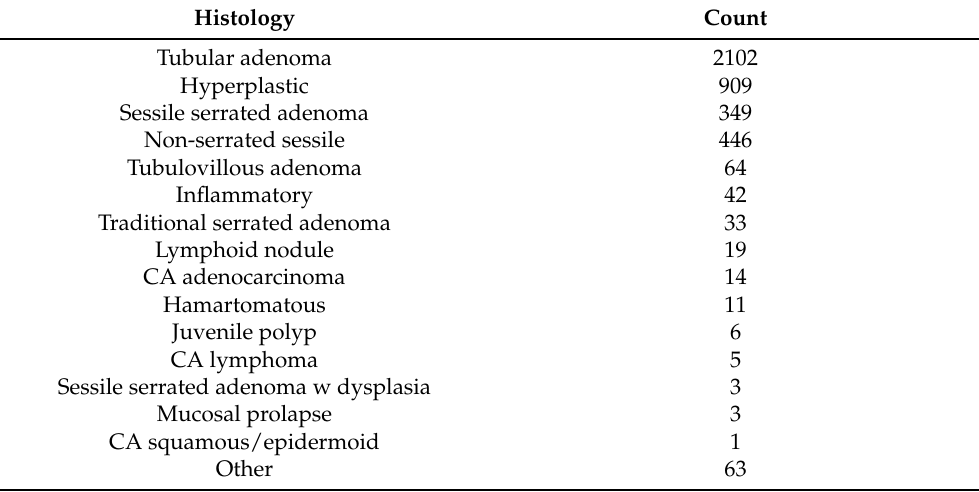
Table 1. Histology information for 4070 polyp images from the Polyp-Box-Seg dataset. Histology Count Tubular adenoma 2102 Hyperplastic 909 Sessile serrated adenoma 349 Non-serrated sessile 446 Tubulovillous adenoma 64 Inflammatory 42 Traditional serrated adenoma 33 Lymphoid nodule 19 CA adenocarcinoma 14